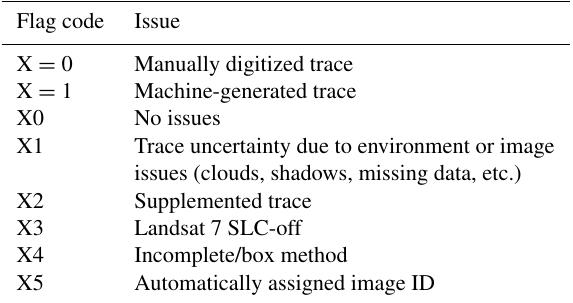
Table 3. Flags assigned to output terminus trace data, created in conjunction with CALFIN (Cheng et al., 2021). All data in the TermPicks data set have the prefix of X =